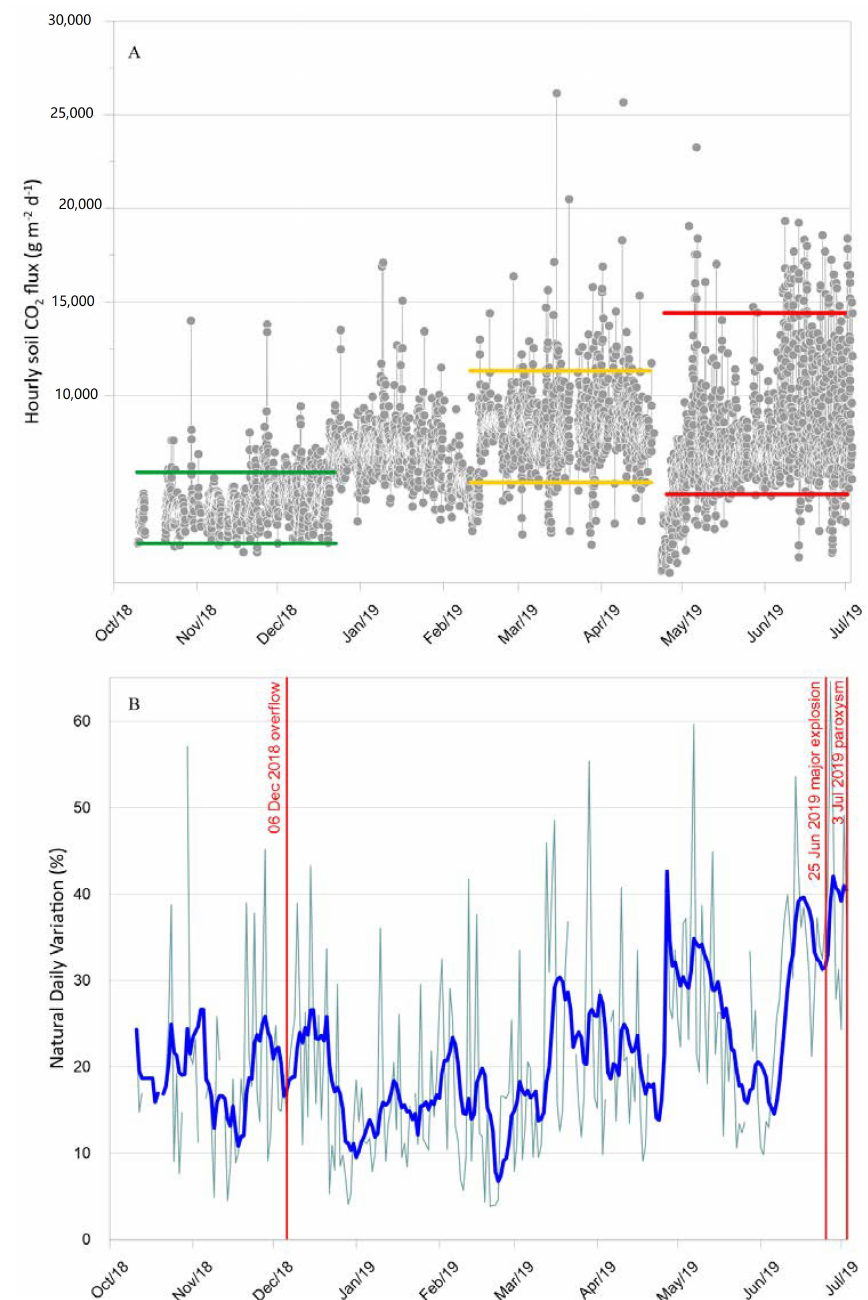
Figure 3. ( A ) Hourly CO 2 fluxes of STR02 in the period from October 2018 to July 2019. Changes in the style of shallow degassing (green horizontal line represents the background level) with a progressively increased variability of daily CO 2 fluxes have been observed in March and May, as evidenced by yellow and red lines. ( B ) Natural daily variations (NDV; [2]) of hourly CO 2 fluxes expressed as daily (24 measurements) normalized standard deviation in per cent [2]. The blue line is the weekly average value of NDV, which showed a significant increment from March 2019 up to early